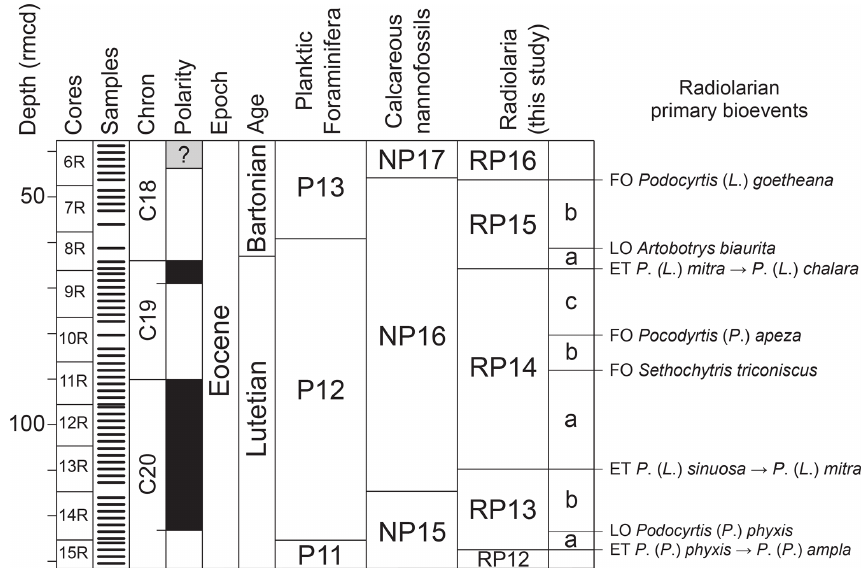
Figure 5. Biostratigraphic summary of calcareous and siliceous microfossils at ODP Site 1260 after the biostratigraphic results of the Shipboard Scientific Party (2004) and of this study, including the newly defined radiolarian subzones. The geomagnetic timescale used is after Suganuma and Ogg (2006). FO: first occurrence, LO: last occurrence, ET: evolutionary